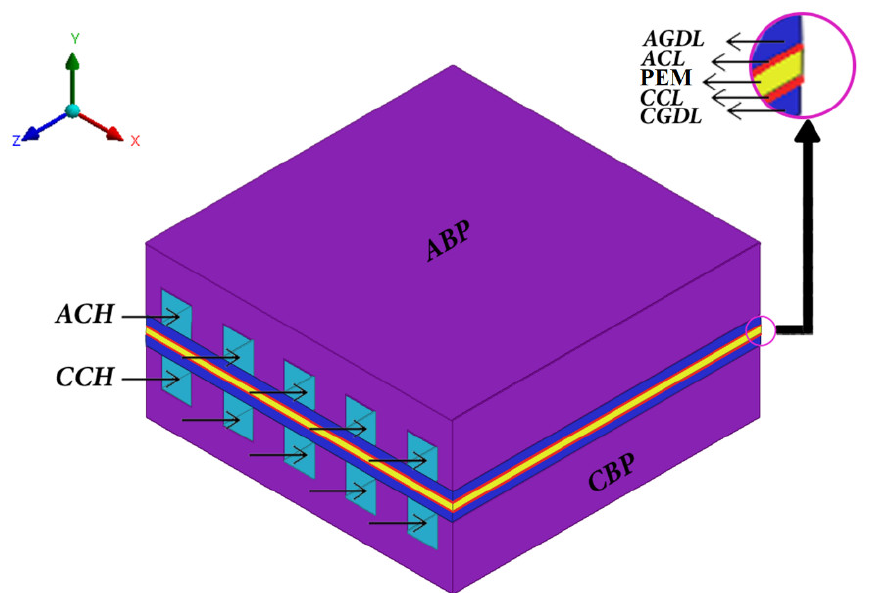
Figure 1. Schematic diagram of a typical PEMWE.